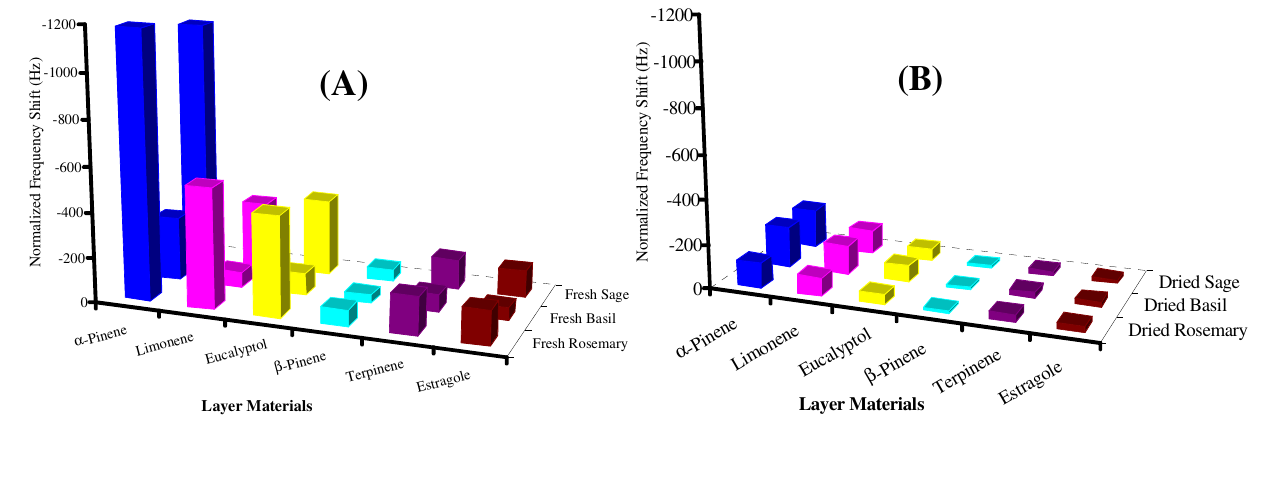
Figure 7. Selectivity patterns of e-nose, (A) Emanated terpenes from fresh herbs, (B) Emanated terpenes from dried herbs. Normalized at layer height = 40 nm, actual layer height = 180–240